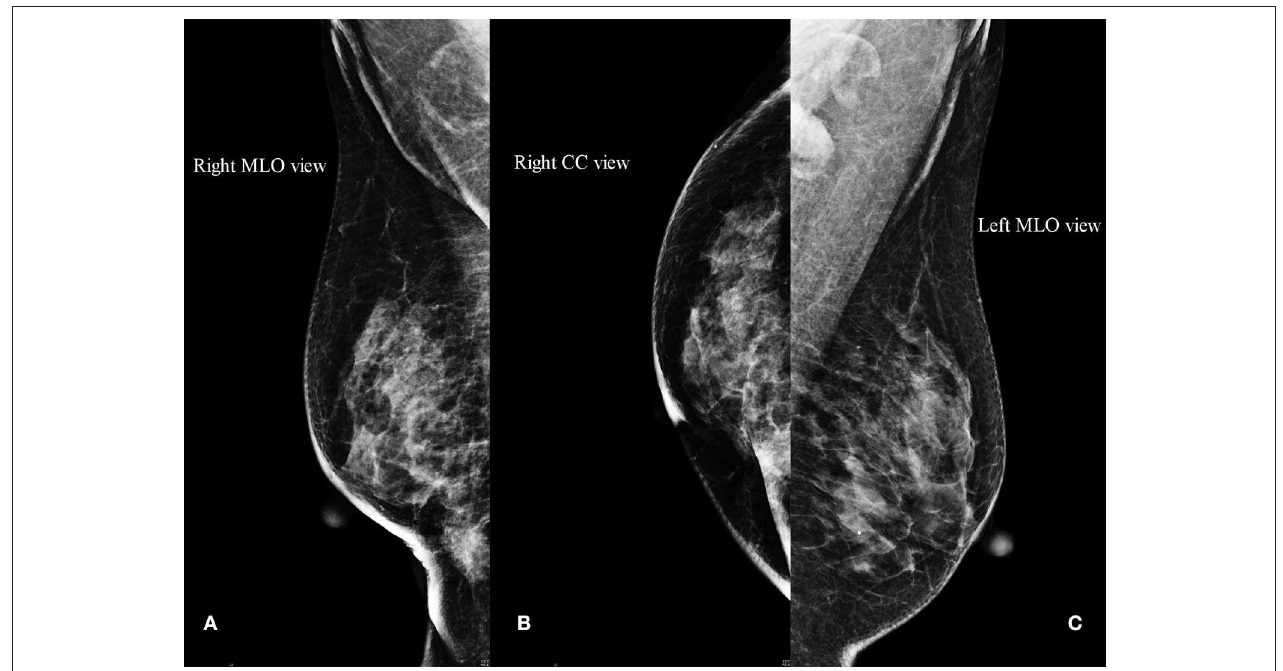
FIGURE 3 | Mammogram. (A,B) An abnormal density shadow in the lower inner quadrant of the right breast suspected to be malignant lesions. (C) Enlarged left axillary lymph